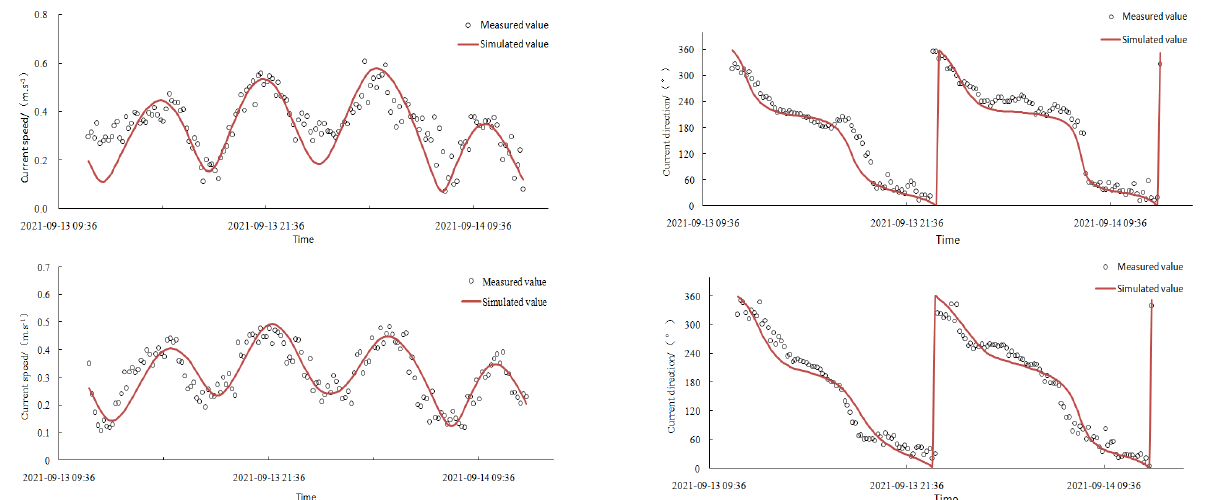
Figure 6. Verification of flow rates and directions at P1 and P2.